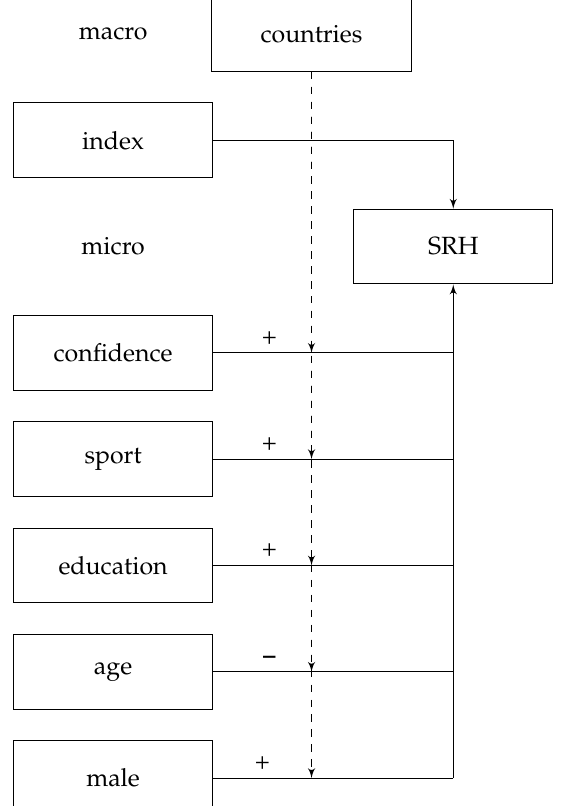
Figure 2. Full multilevel model for validating the created index. SRH = self-rated health, confidence = confidence in the health care system, dashed arrows indicate the potential influence through, for example, laws or regulations of countries at the micro